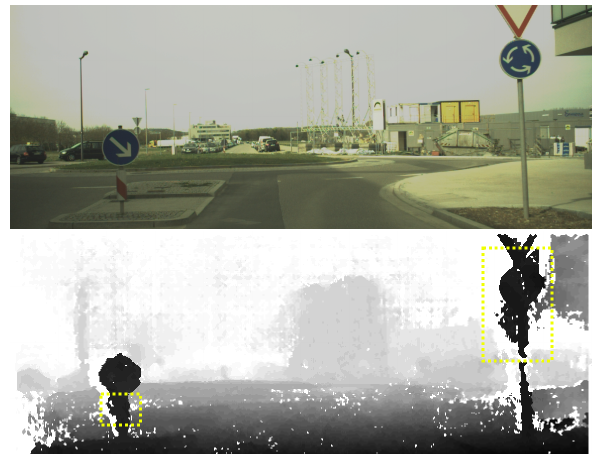
Figure 1. Example of SGM failure at object borders in front of a uniform background. Pixel intensities range from near to far from dark to bright. Pixel without disparity value (invalid disparities) are